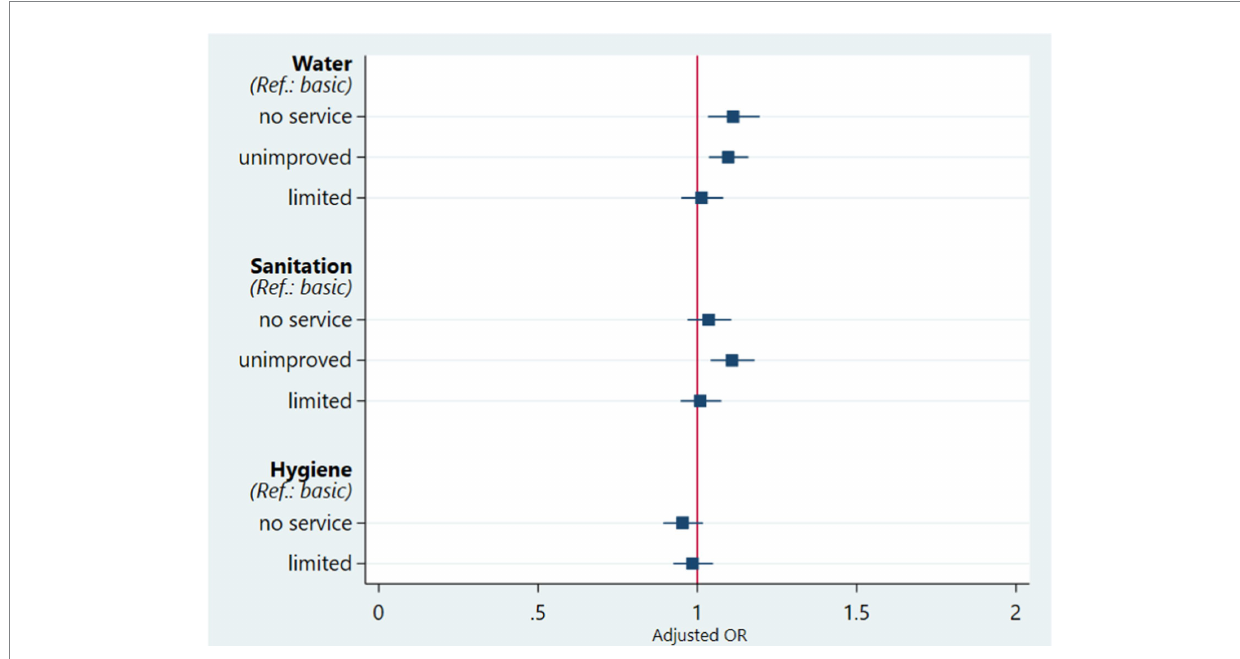
FIGURE 3 Effects of household access to WASH services by mixed logistic regression on under-five mortality, adjusted for covariates in SSA,